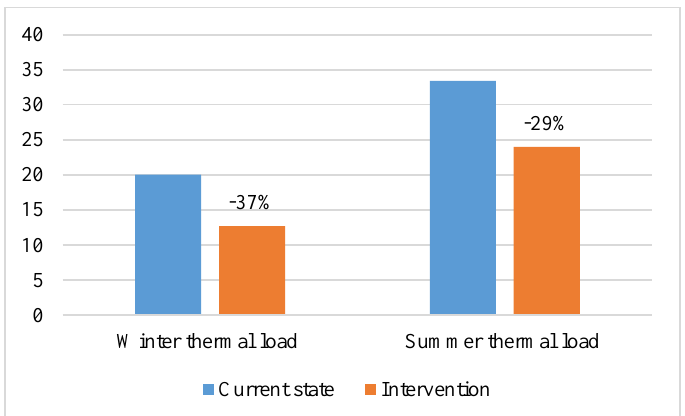
Figure 9. Thermal load (kW) values for the existing building and the insulated one.